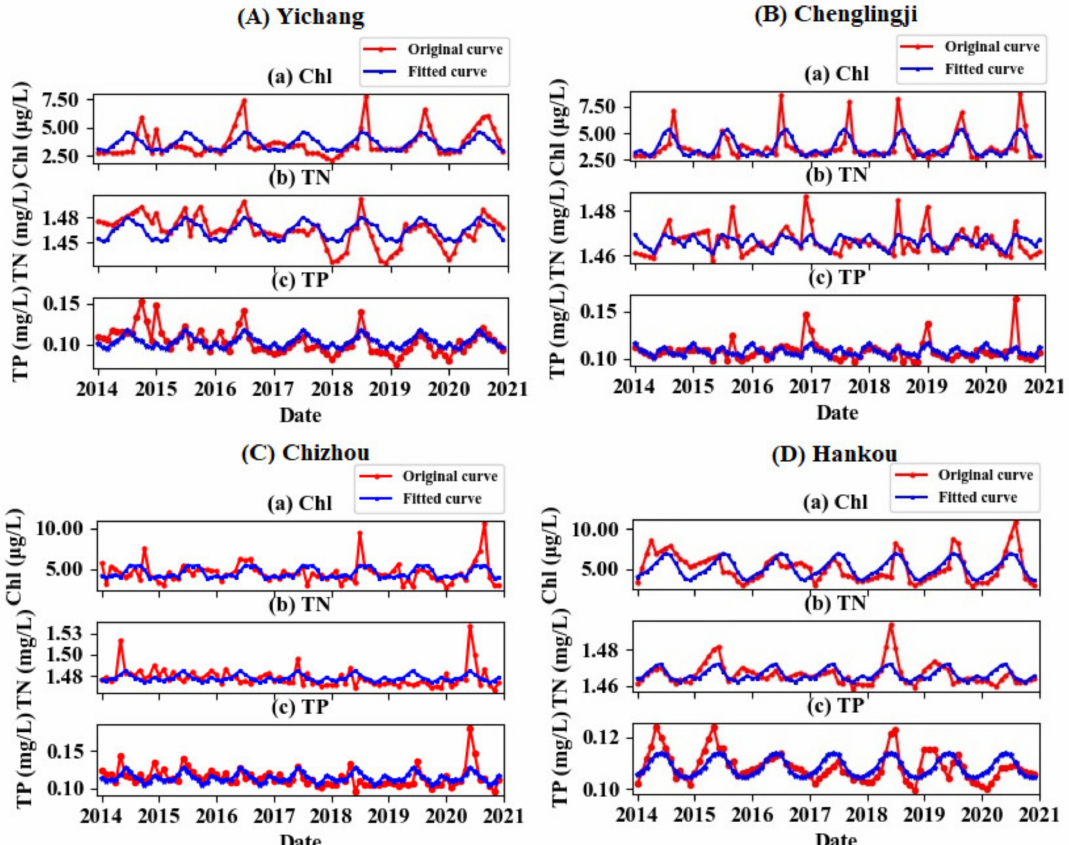
Figure 8. Fitting results of the monthly variations trend of the water quality parameters of the sections in the Yangtze River from 2014 to 2020. ( A – D ) are the sections of Yichang, Hubei, Chenglingji, Hunan, Chizhou, Anhui, and Wuhan, Hubei, respectively.